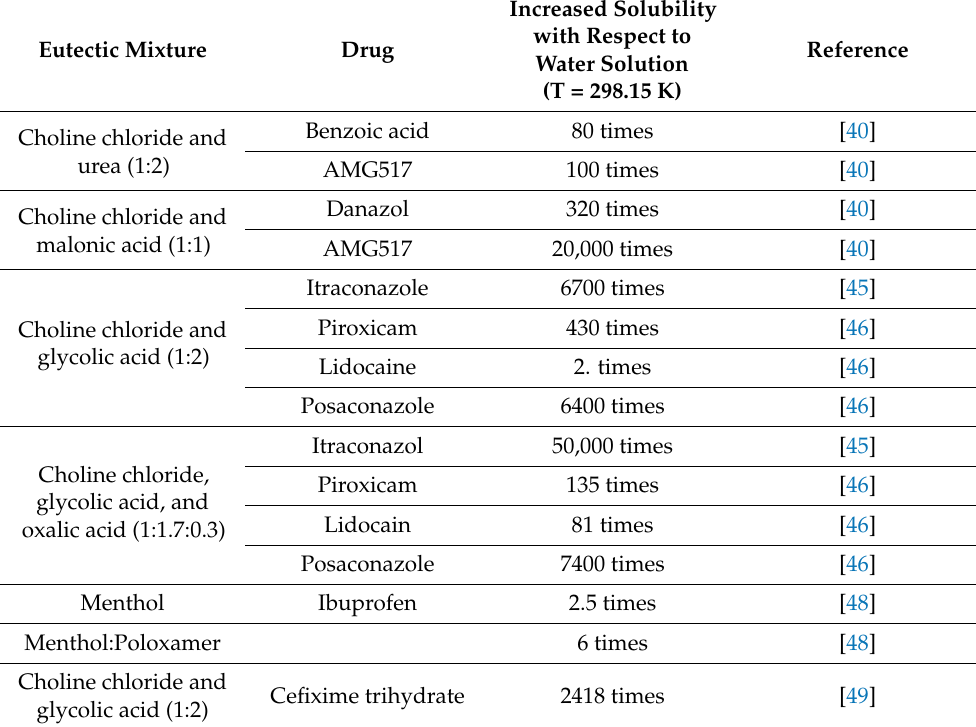
Table 1. List of drug solubility in